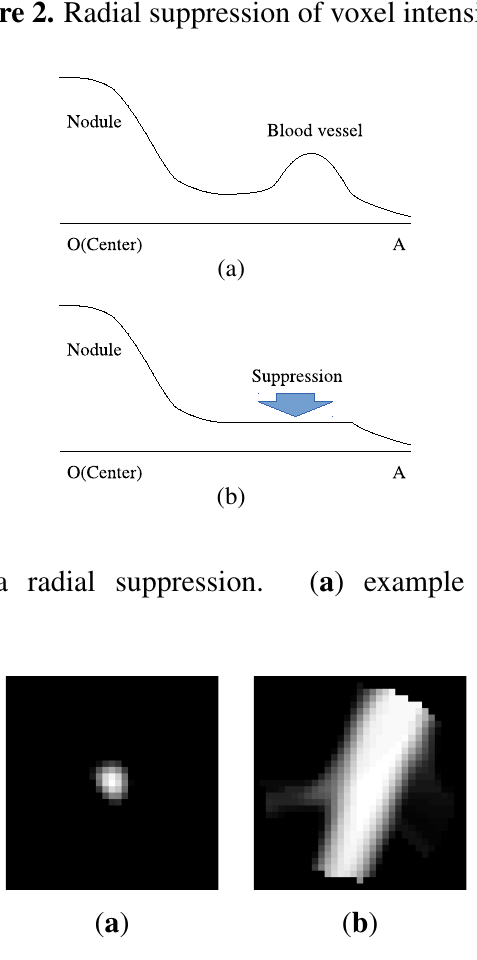
Figure 4. Results obtained by applying the radial suppression filter to the VOIs in Figure 1. ( a ) nodule; ( b ) blood